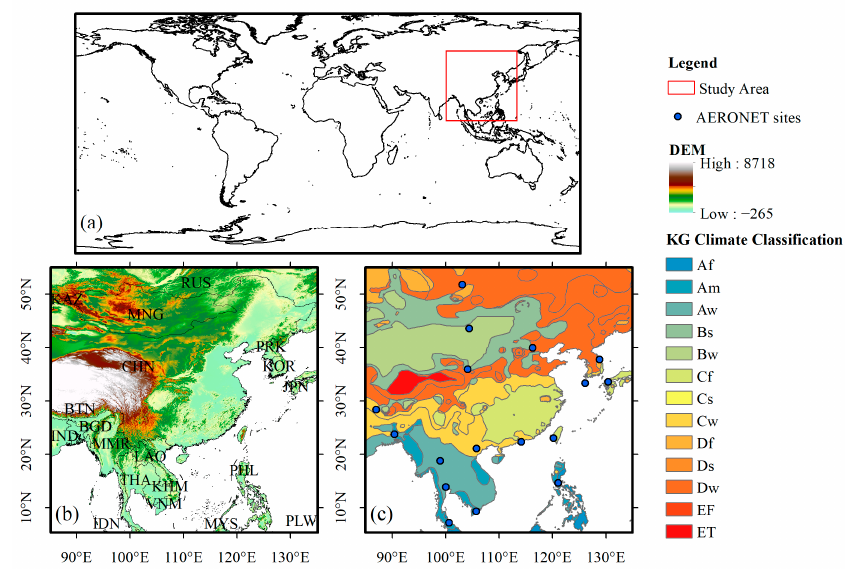
Figure 1. ( a ) Location of the study area in a global map; ( b ) Relevant topography and major countries within the study area (RUS KAZ MNG CHN PRK KOR JPN BTN BGD IND MMR LAO THA KHM VNM PHL MYS PLW); and ( c ) Distribution of climate types and AERONET sites within the study area (Af: Tropical rainforest climate Aw: Tropical open forest climate Am: Tropical monsoon climate BS: Steppe climate BW: Desert climate Cf: Normally humid and warm climate Cs: Dry summer and warm climate Cw: Dry and warm climate in winter Df: Normally humid and cold temperature climate Ds: Subarctic continental climate Dw: Sub-frigid monsoon climate EF: Tundra climate ET: Ice